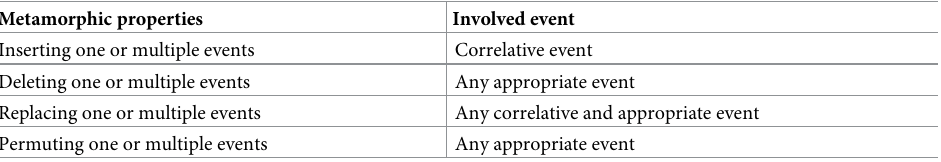
Table 1. Properties of event